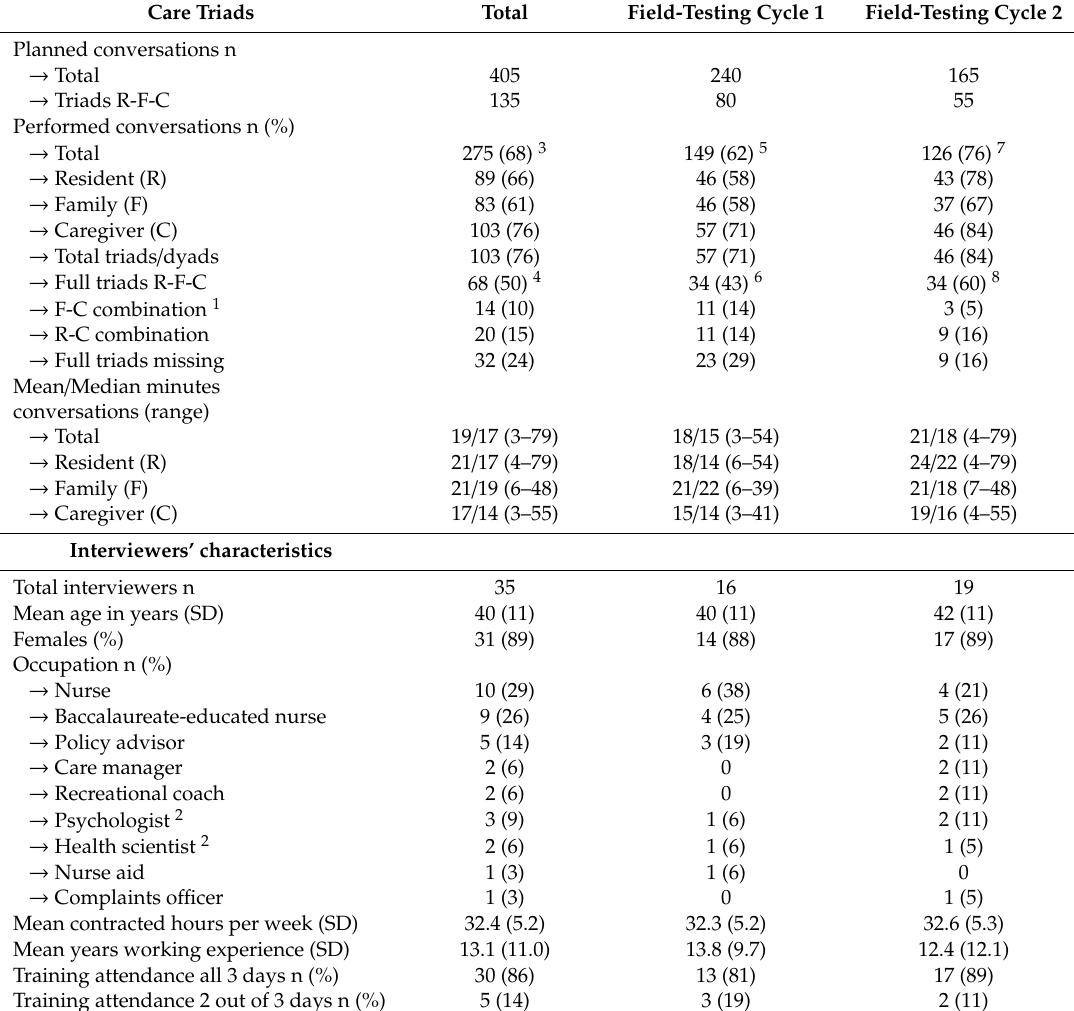
Table 3. Connecting Conversations’ care triads and interviewer